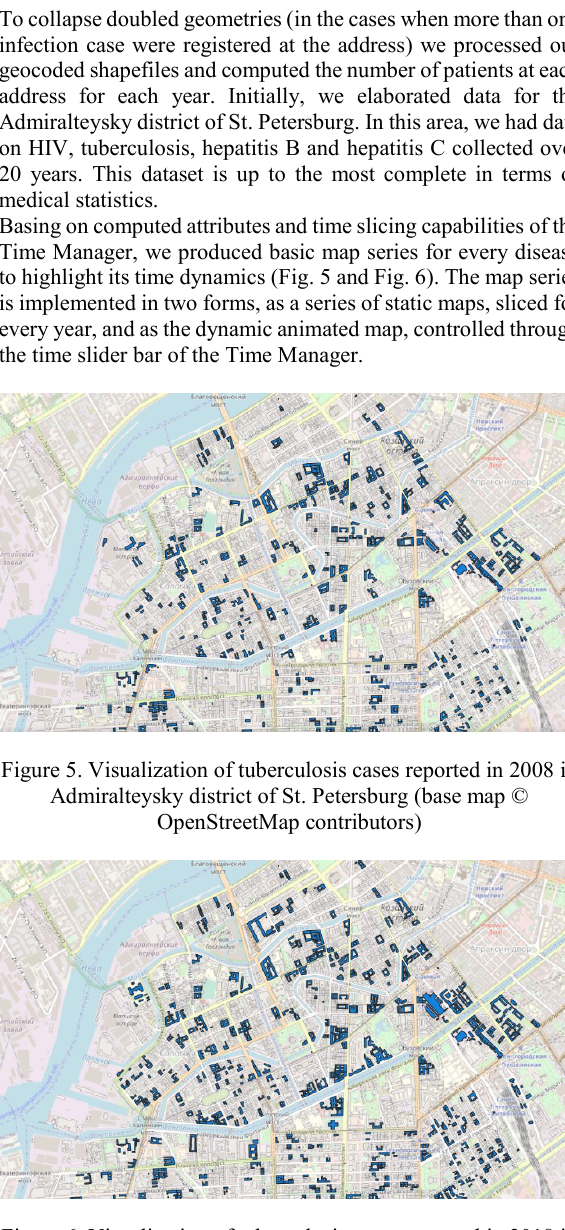
Figure 6. Visualization of tuberculosis cases reported in 2018 in Admiralteysky district of St. Petersburg (base map © OpenStreetMap